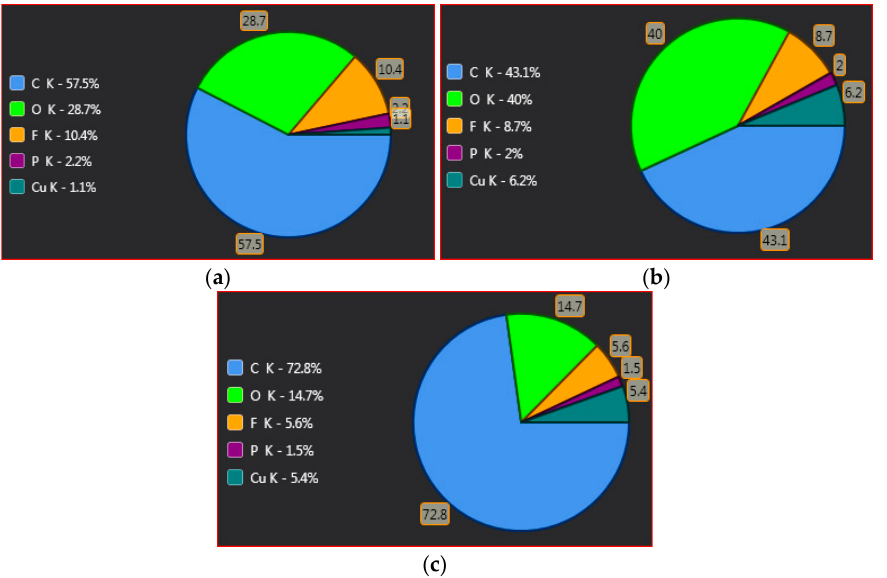
Figure 11. Composition % of the anode of the cell (EDX analysis): ( a ) new, ( b ) overdischarged with a DOD% = 110%, ( c ) overdischarged with a DOD% = 140%.